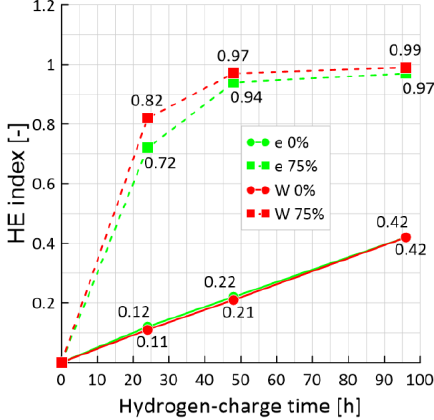
Figure 11. HE index: with 0% (solid curves) and 75% (dashed curves) pre-strain samples; red curves — according to the energy approach, green curves — according to the strain approach.